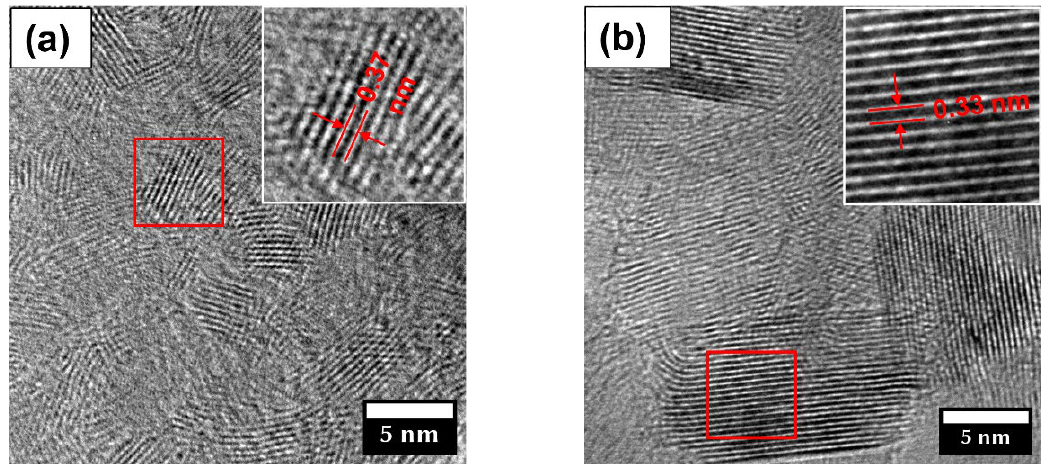
Figure 6. TEM images of the BNO 1 ( a ) and BNO 2 ( b ) samples. Insets show enlarged areas marked with red rectangles (red lines and arrows mark atomic planes).